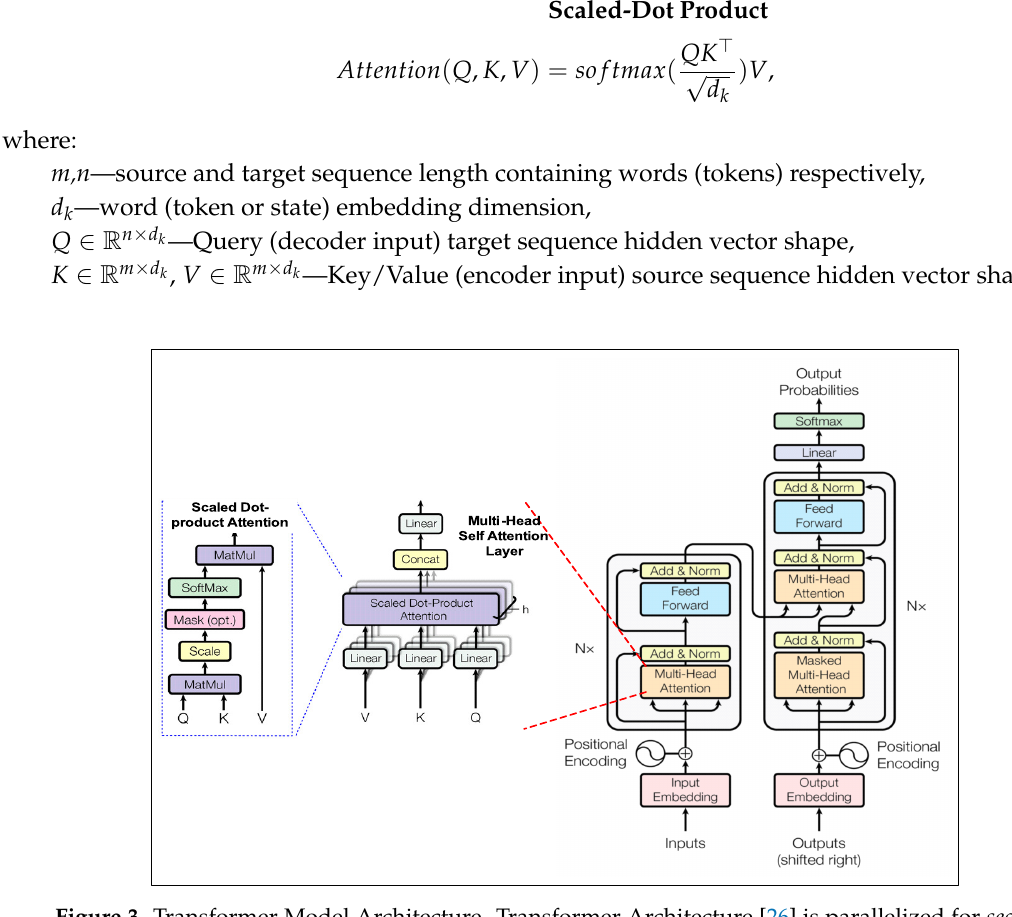
Figure 3. Transformer Model Architecture. Transformer Architecture [26] is parallelized for seq2seq applications which is neither CNN nor RNN based. Encoder-decoder branches consists of stacked multi-headed self-attention layers with scaled-dot product